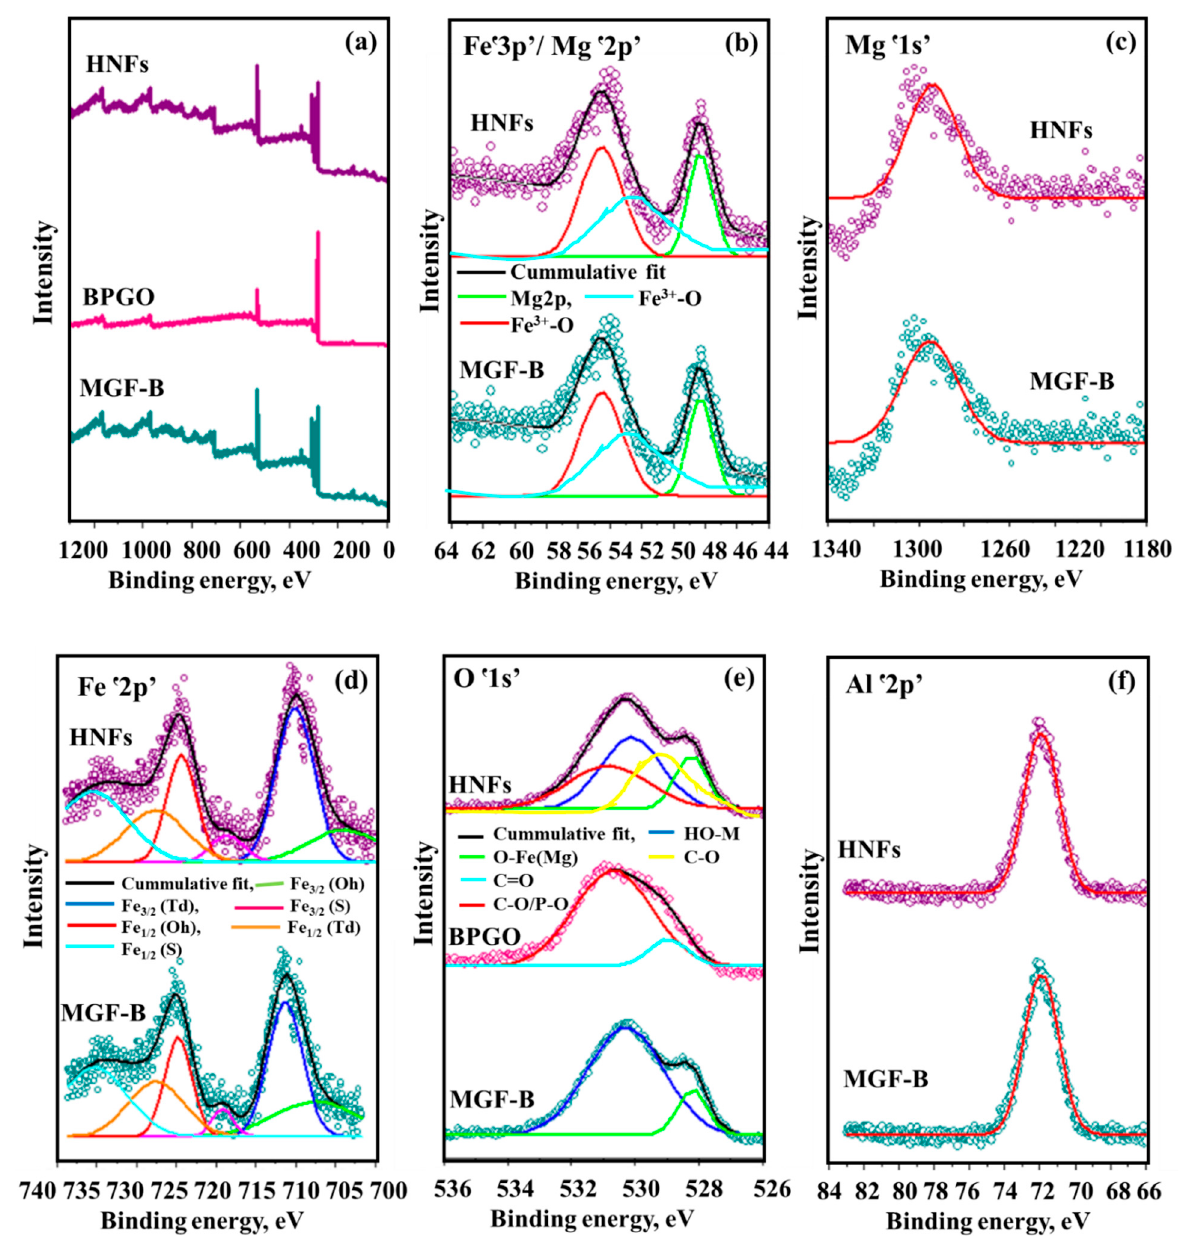
Figure 1. XPS spectra ( a ) Full scan spectrum and XPS high resolution spectra of ( b )